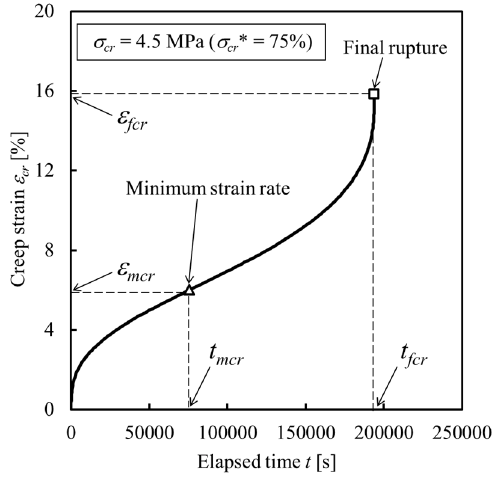
Figure 6. Creep strain ε cr versus elapsed time t [22,24].